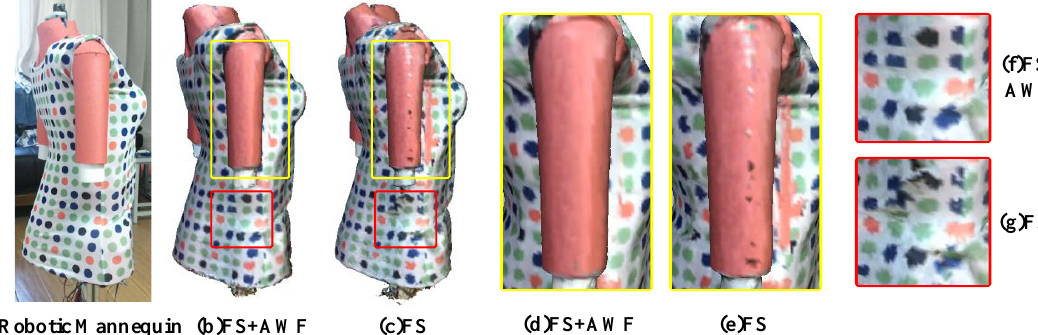
Figure 11. The validation of the color adaptive weight field, ( a ) is the used robotic mannequin and customized clothing; ( b , d , f ) are the results obtained by using the new fusion strategy (FS) and the adaptive weight field (AWF); ( c , e , g ) are the results obtained only by using the new fusion strategy (FS).